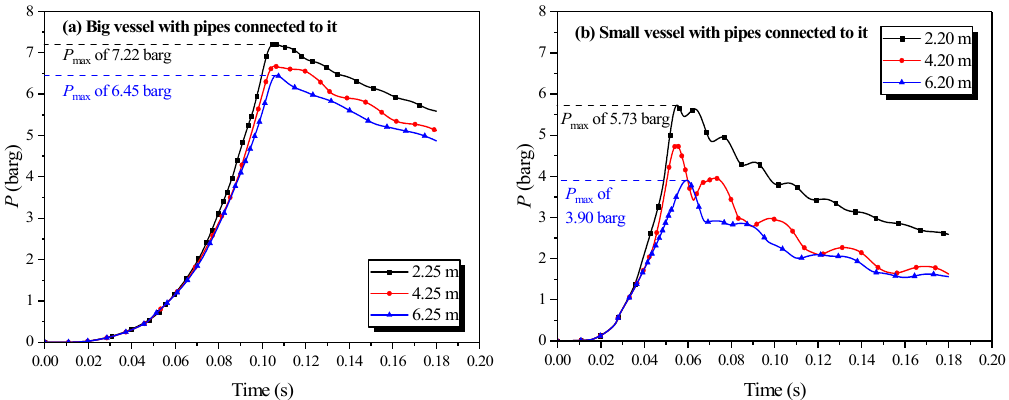
Figure 9. Natural gas explosion pressure versus time by changing the length of the pipe connected to the single vessel.